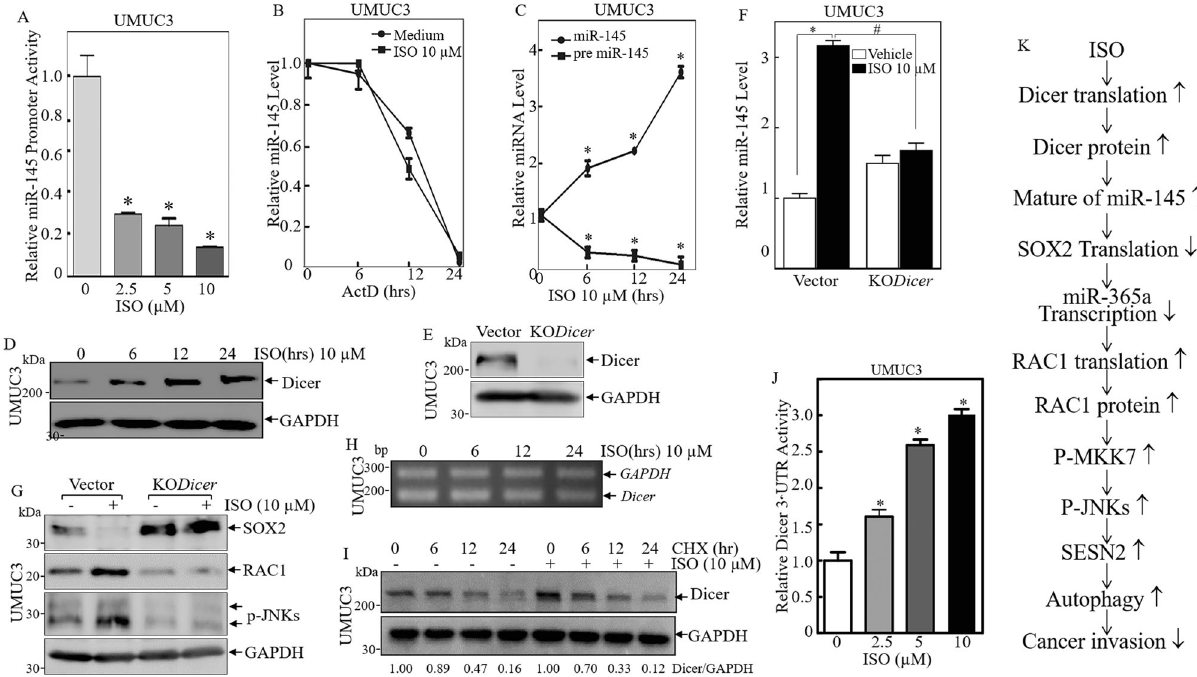
Fig. 6 ISO treatment accumulated Dicer and in turn, upregulated miR-145 maturation and expression. A UMUC3 stably transfected with miR-145 promoter-driven luciferase reporter was treated with ISO at different concentrations for 24 h to determine the potential effect of ISO on miR-145 promoter transcriptional activity. B UMUC3 cells were co-incubated with ISO (10 μ M) and Act D (20 μ g/ml) for indicated time periods. Total RNA was isolated and quantitative real-time PCR was then performed to determine miR-145 levels. GAPDH was used as internal control. The result was a representative one from three independent experiments. C The relative expression levels of pre-mir-145 and miR-145 were evaluated by quantitative real-time PCR in UMUC3 followed by ISO treatment at different concentrations for 24 h. * Signi fi cant change from vehicle control ( p < 0.05). D UMUC3 cells were treated with various concentrations of ISO for 24 h. The cell lysates were subjected to Western blot to detect Dicer protein expression. E CRISPR/Cas9 for Dicer was stably transfected into UMUC3 cells, and the stable cells were identi fi ed with Western blot. F UMUC3(KO Dicer ) and UMUC3(Vector) cells were treated with or without 10 μ M of ISO for determination of miR- 145 level using Real-time PCR. G Cell extracts from UMUC3(KO Dicer ) and UMUC3(Vector) were subjected to Western blot to evaluate the downstream protein expression following treatment with 10 μ M of ISO for 24 h. H Total RNA was isolated from the UMUC3 cells treated with 10 μ M of ISO for indicated time periods. RT-PCR was performed to determine Dicer mRNA levels. The GAPDH mRNA levels were used as loading control. I UMUC3 were pre-treated with MG132(10 μ M) for 6 h, and the cells were then incubated with CHX (100 µg/ml) for the indicated time periods with or without ISO (10 μ M). The cell extracts were then subjected to Western blot to analyze Dicer protein degradation rates. GAPDH was used as a protein loading control. J Dicer 3 ′ -UTR luciferase reporter was transiently transfected into UMUC3 cells, and the transfectants were subjected to determine the effect of ISO on Dicer mRNA 3 ′ -UTR activity in UMUC3 cells following ISO treatment for 24 h. * Signi fi cant increase of Dicer 3 ′ -UTR activity in comparison to vehicle control ( p < 0.05). The results were shown as Mean ± SD from three independent experiments. K The schematic summary of molecular mechanisms underlying the anti-cancer activity of ISO on human bladder cancer